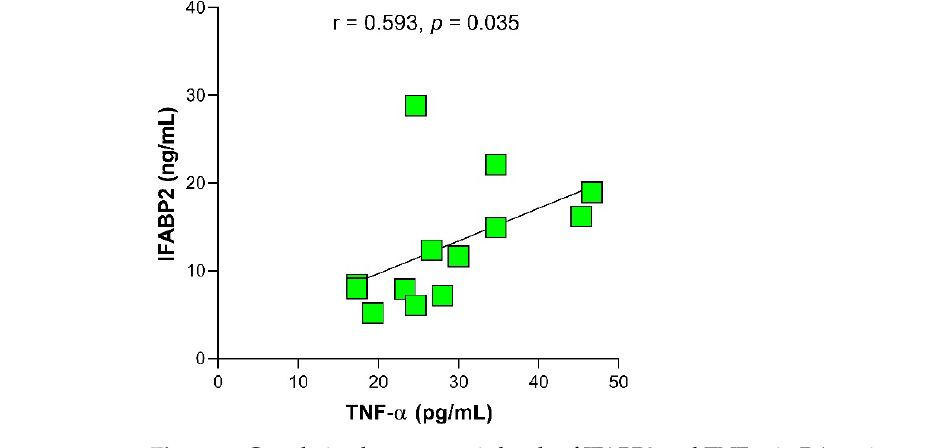
Figure 2. Correlation between seric levels of IFABP2 and TNF- α in RA patients with treatment. Spearman’s correlation. r = rho, correlation coefficient. p -Value < 0.05 was considered statistically significant.